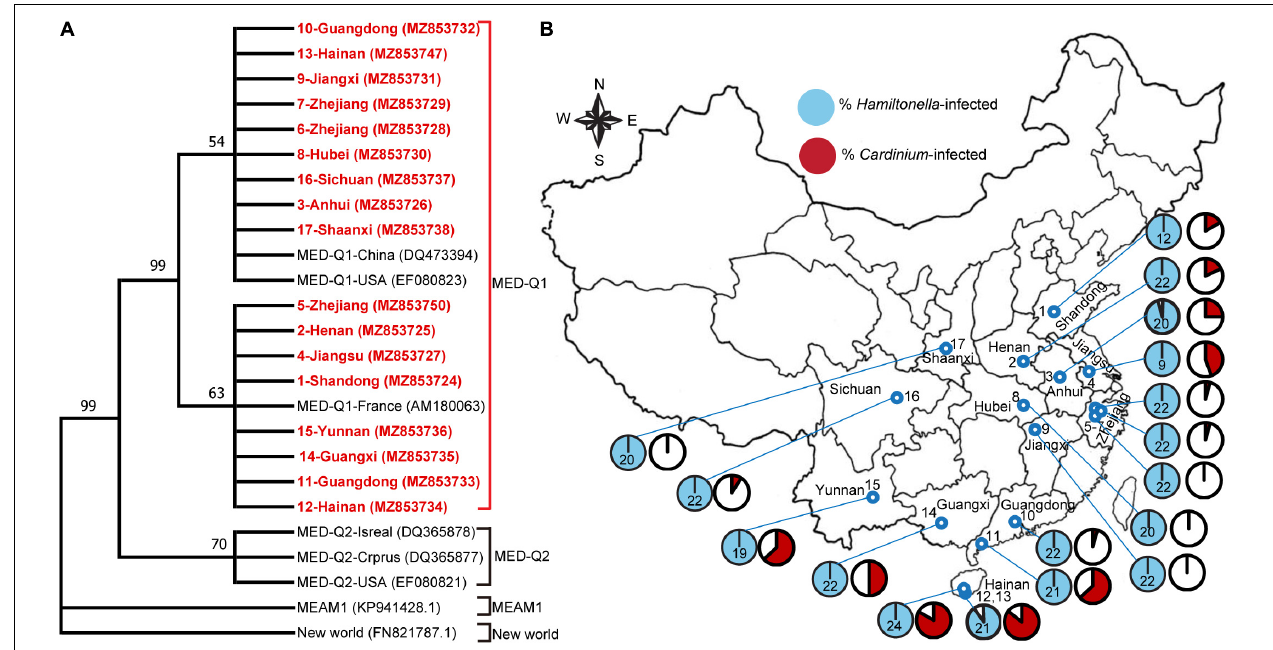
FIGURE 1 | The infection of secondary symbionts in field MED whitefly populations sampled in various locations in China. (A) Phylogenetic tree of the different whitefly populations based on the mtCOI sequences ( ∼ 760 bp). Maximum Likelihood algorithms available in MEGA-X were used to infer phylogenetic relationships of the sequences that are shown as a cladogram. The mtCOI sequences of 17 MED populations from this study are indicated in bold red. The Genbank accession number is shown in bracket. Bootstrap values ( > 50%) are shown on branches. (B) Infection frequencies of Cardinium and Hamiltonella in various geographical populations. The numbers in the map indicated the whitefly population No. The number in each of the pie charts indicates the sample size for PCR screens in that population. For details of the sample collection information, see Supplementary Table 1 .